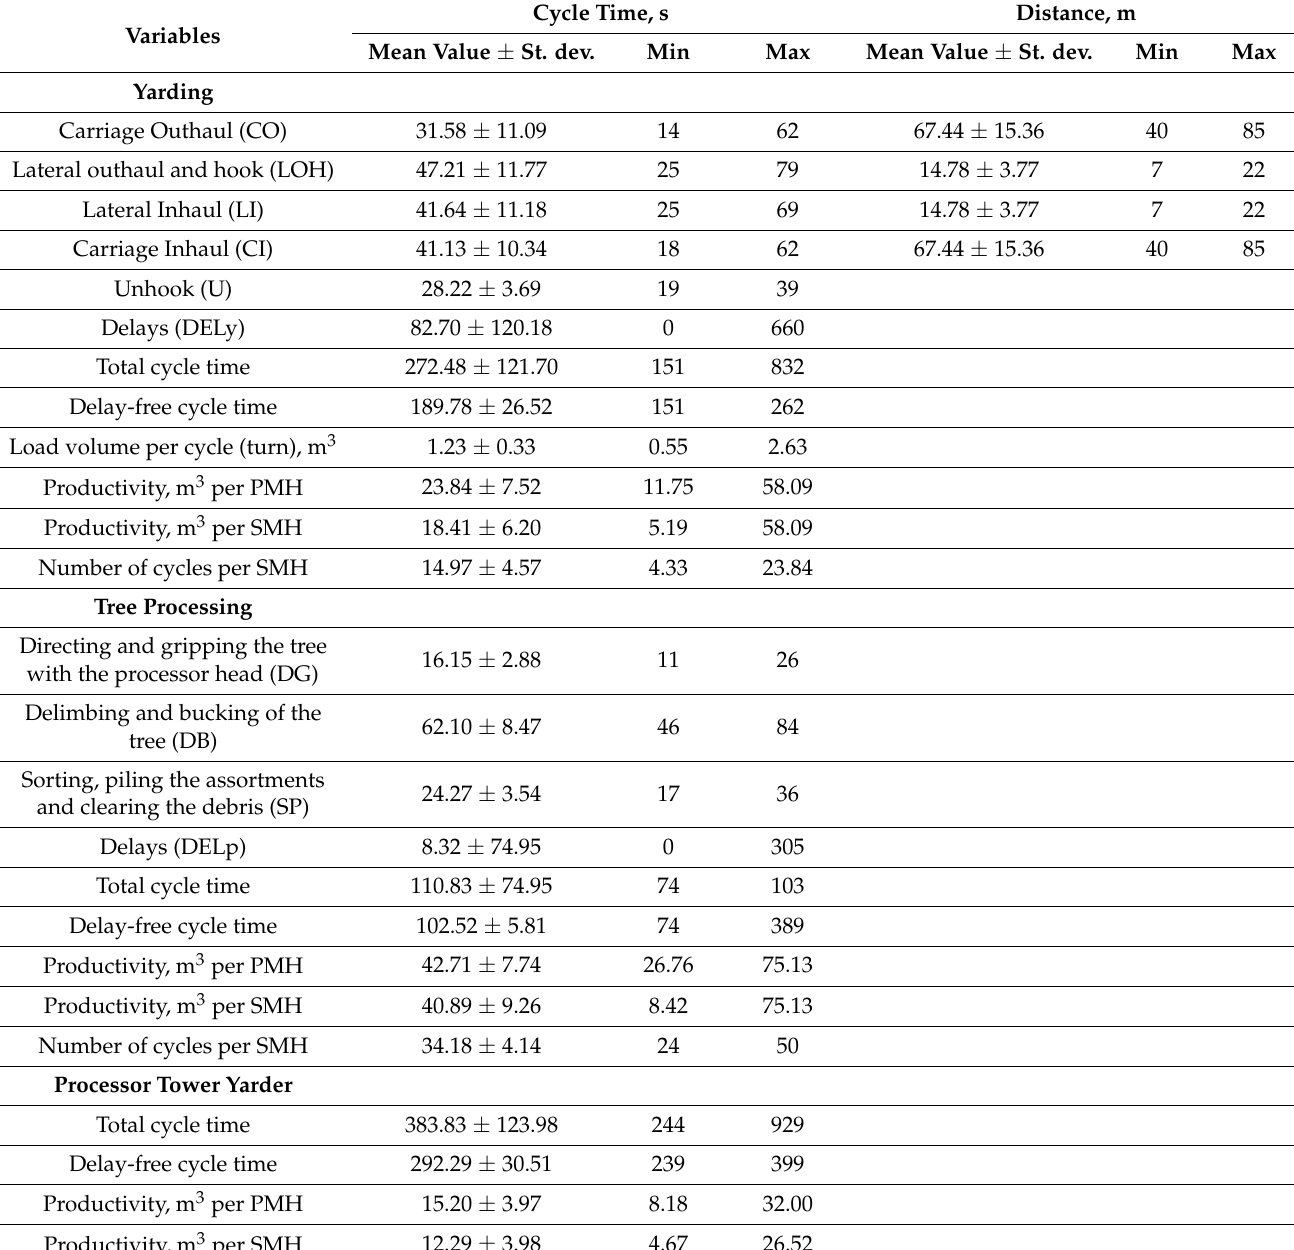
Table 3. Mean experimental